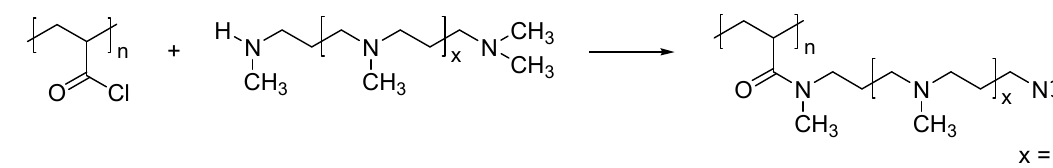
Figure 1. Scheme of the polymer synthesis.